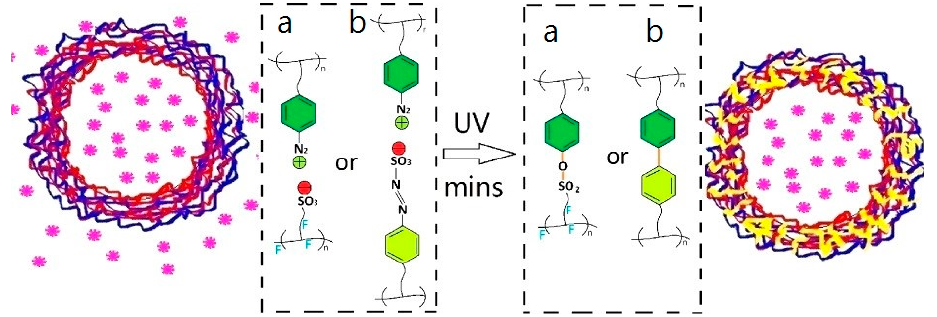
Figure 5. Photolysis-induced small molecule encapsulation in: ( a ) Nafion/DAR; and ( b ) DAR single component multilayer capsules as depicted in [57]. Reprinted with permission from [57]. Copyright 2013 American Chemical Society.